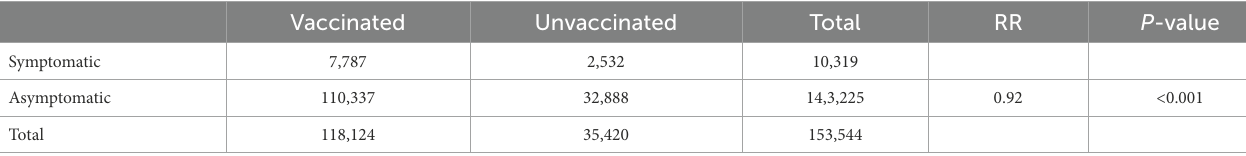
TABLE 3 Occurrence of any COVID-19 related clinical symptoms by vaccination